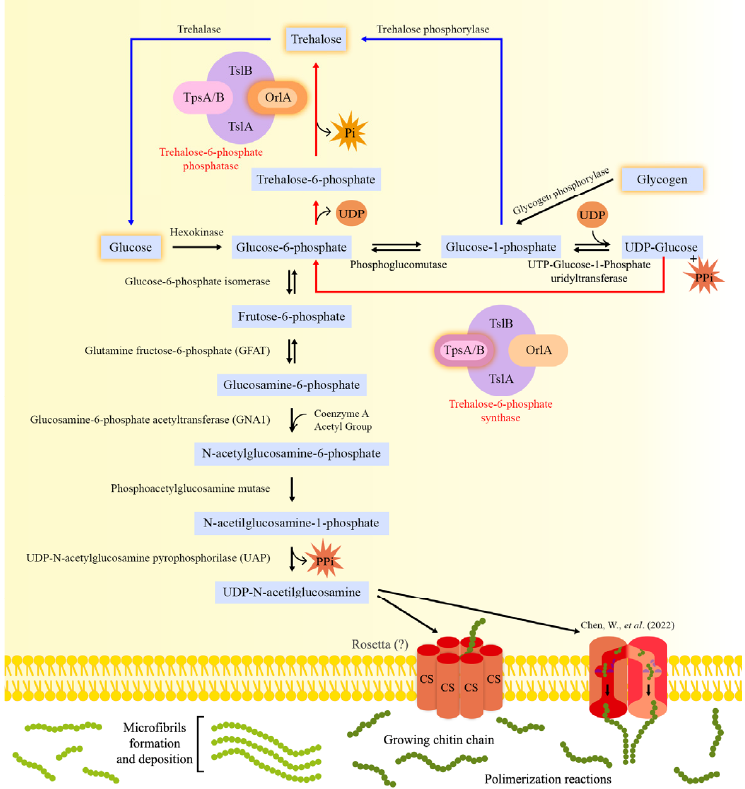
Figure 1. The chitin biosynthesis pathway in Aspergillus. Glucose-6-phosphate (G6P) is the precursor for UDP-N-acetylglucosamine (UDP-N-GlcNAc), the main building block of fungal chitin. Glucose is first converted to G6P by hexokinase and then to fructose-6-phosphate (F6P) by G6P isomerase, before an additional 4 enzymatic steps result in the biosynthesis of UDP-N-GlcNAc.